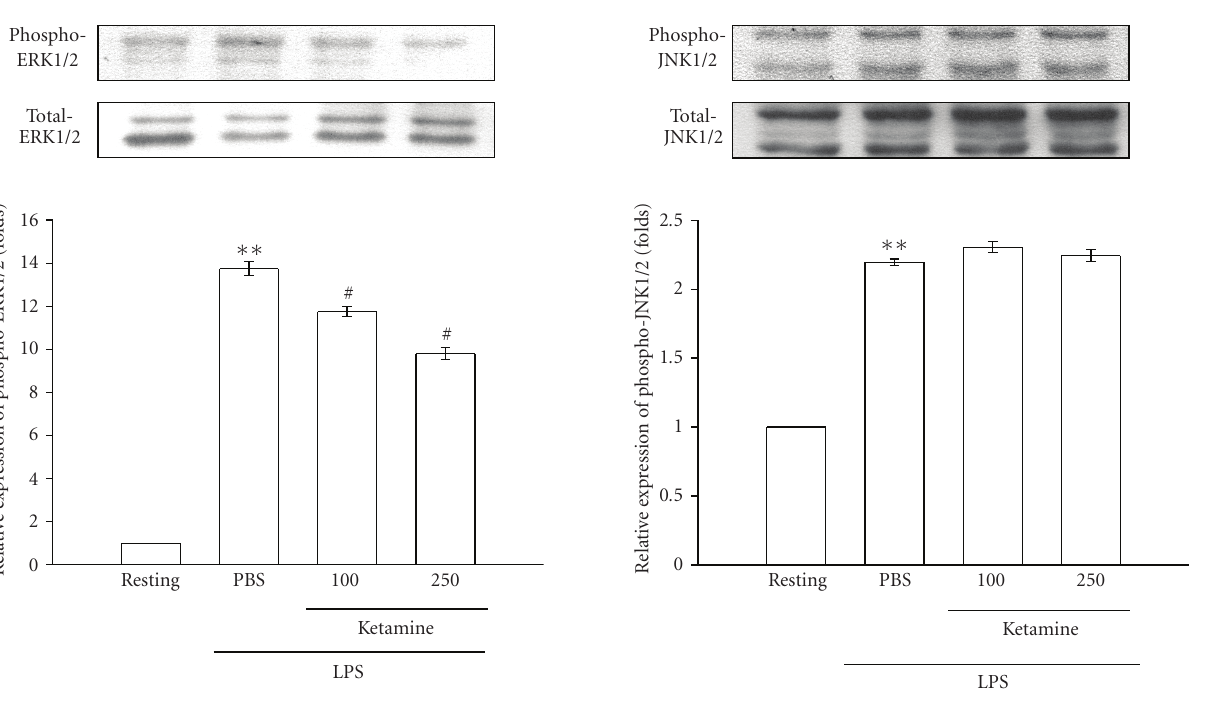
Figure 5: E ff ect of ketamine on ERK1/2 phosphorylation in lipopolysaccharide (LPS)-activated microglia. Microglia (5 × 10 5 cells mL − 1 ) were treated with ketamine (100 and 250 μ M) or an isovolumetric PBS bu ff er for 30 minutes, followed by the addition of LPS (100ngmL − 1 ) for 45 minutes. ERK1/2 phosphorylation was determined by Western blotting with a monoclonal antibody which recognizes only phosphorylated ERK1/2 (p42/p44). Data are presented as the means ± S.E.M. ( n = 3). ∗∗ P < . 01, compared to the resting group; # P < . 05, compared to the PBS-treated group.